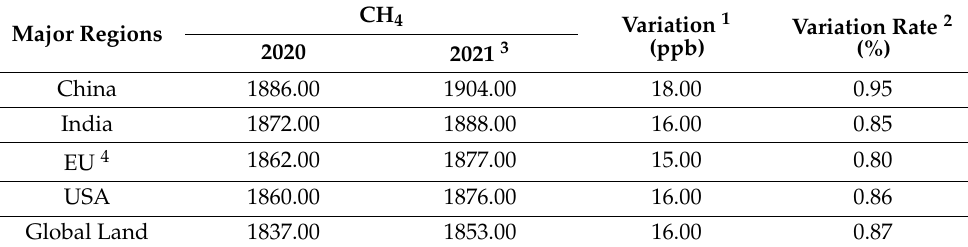
Table 2. Annual CH 4 concentrations and changing rates for global land and major countries/regions in 2020 and 2021.